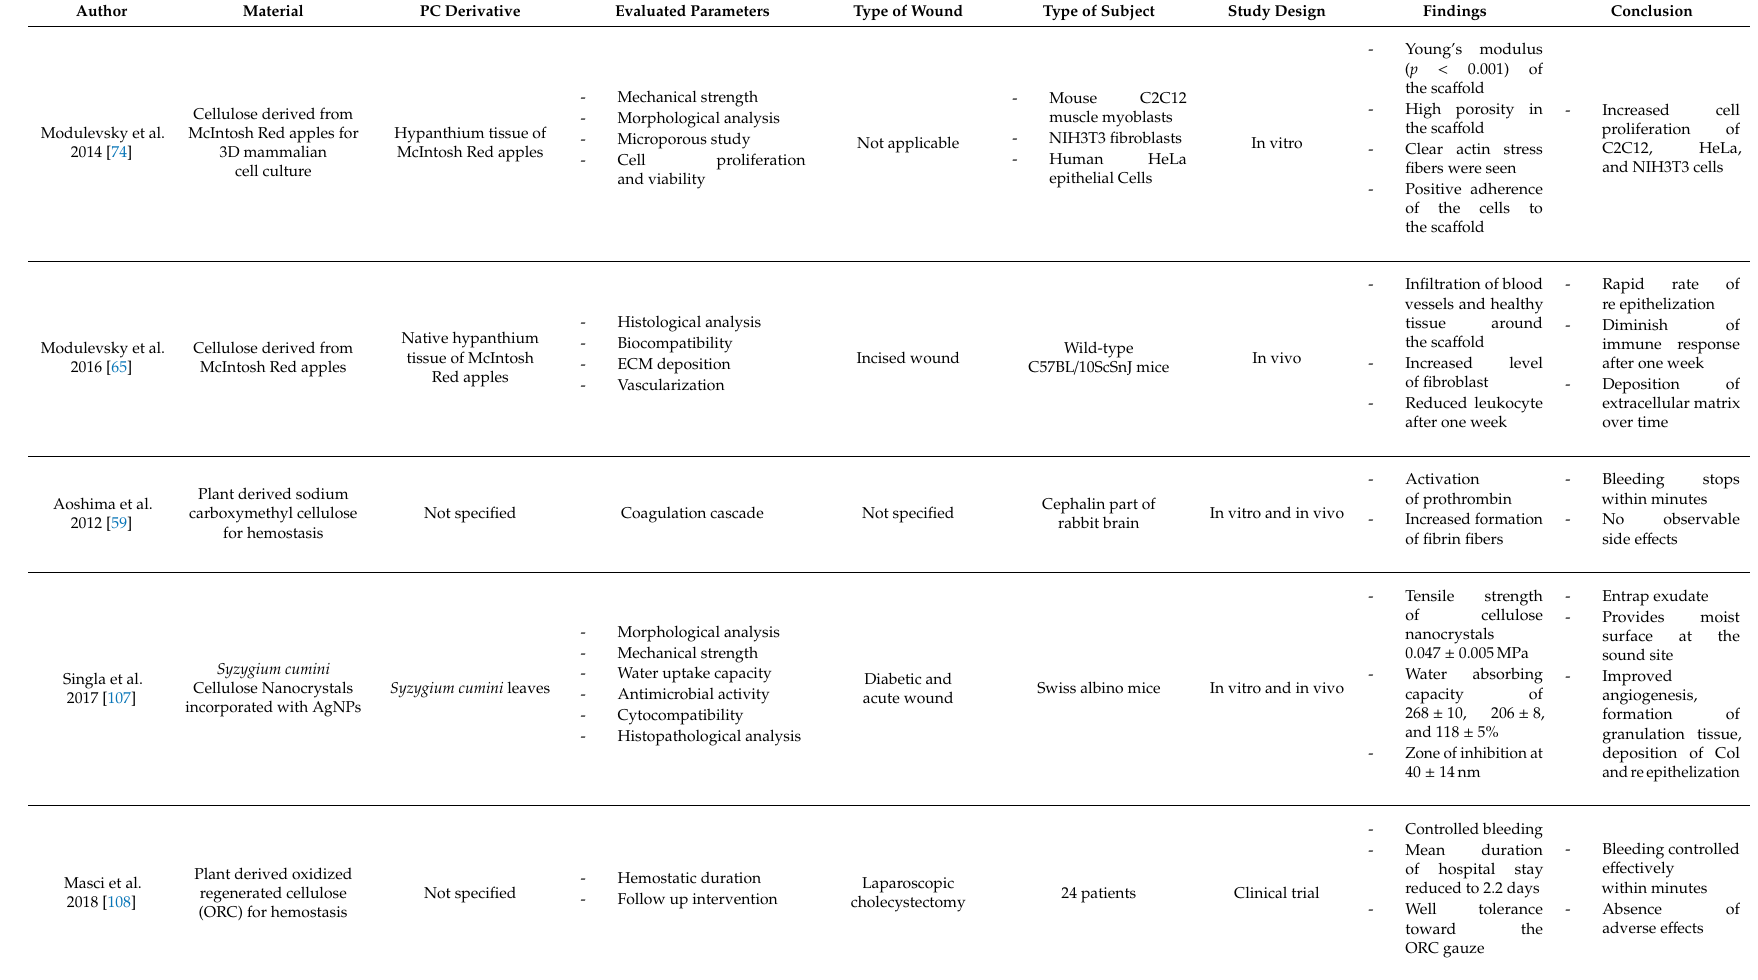
Table 2. In vivo, in vitro and clinical trial studies of plant